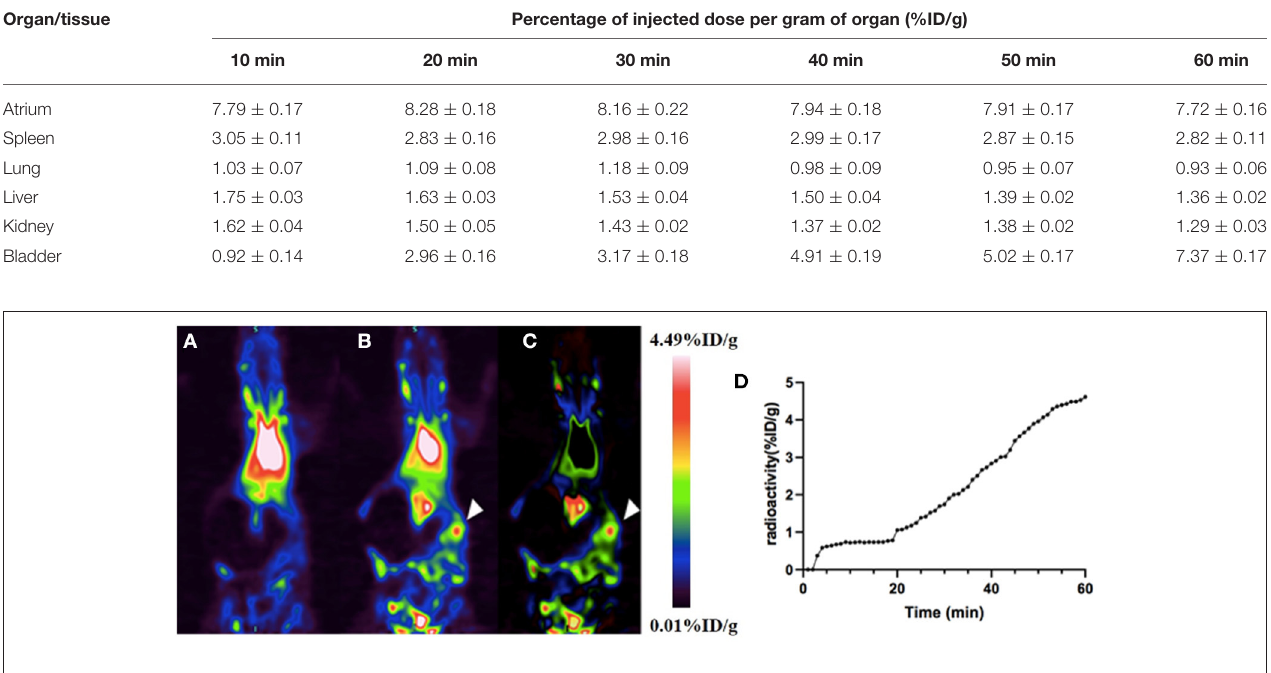
FIGURE 4 | The application of 18 F-VS-RBCs for PET imaging of the intra-abdominal hemorrhage model. The maximum-density projection image before (A) and after (B) bleeding and the subtraction image between the two (C) . The subtracted image showed heavy bleeding in the right abdomen (arrowheads). The time–activity curve of extravascular radioactivity in the abdominal hemorrhage area. Radioactivity continued to increase after manual puncture of the colon wall (18min) (D)